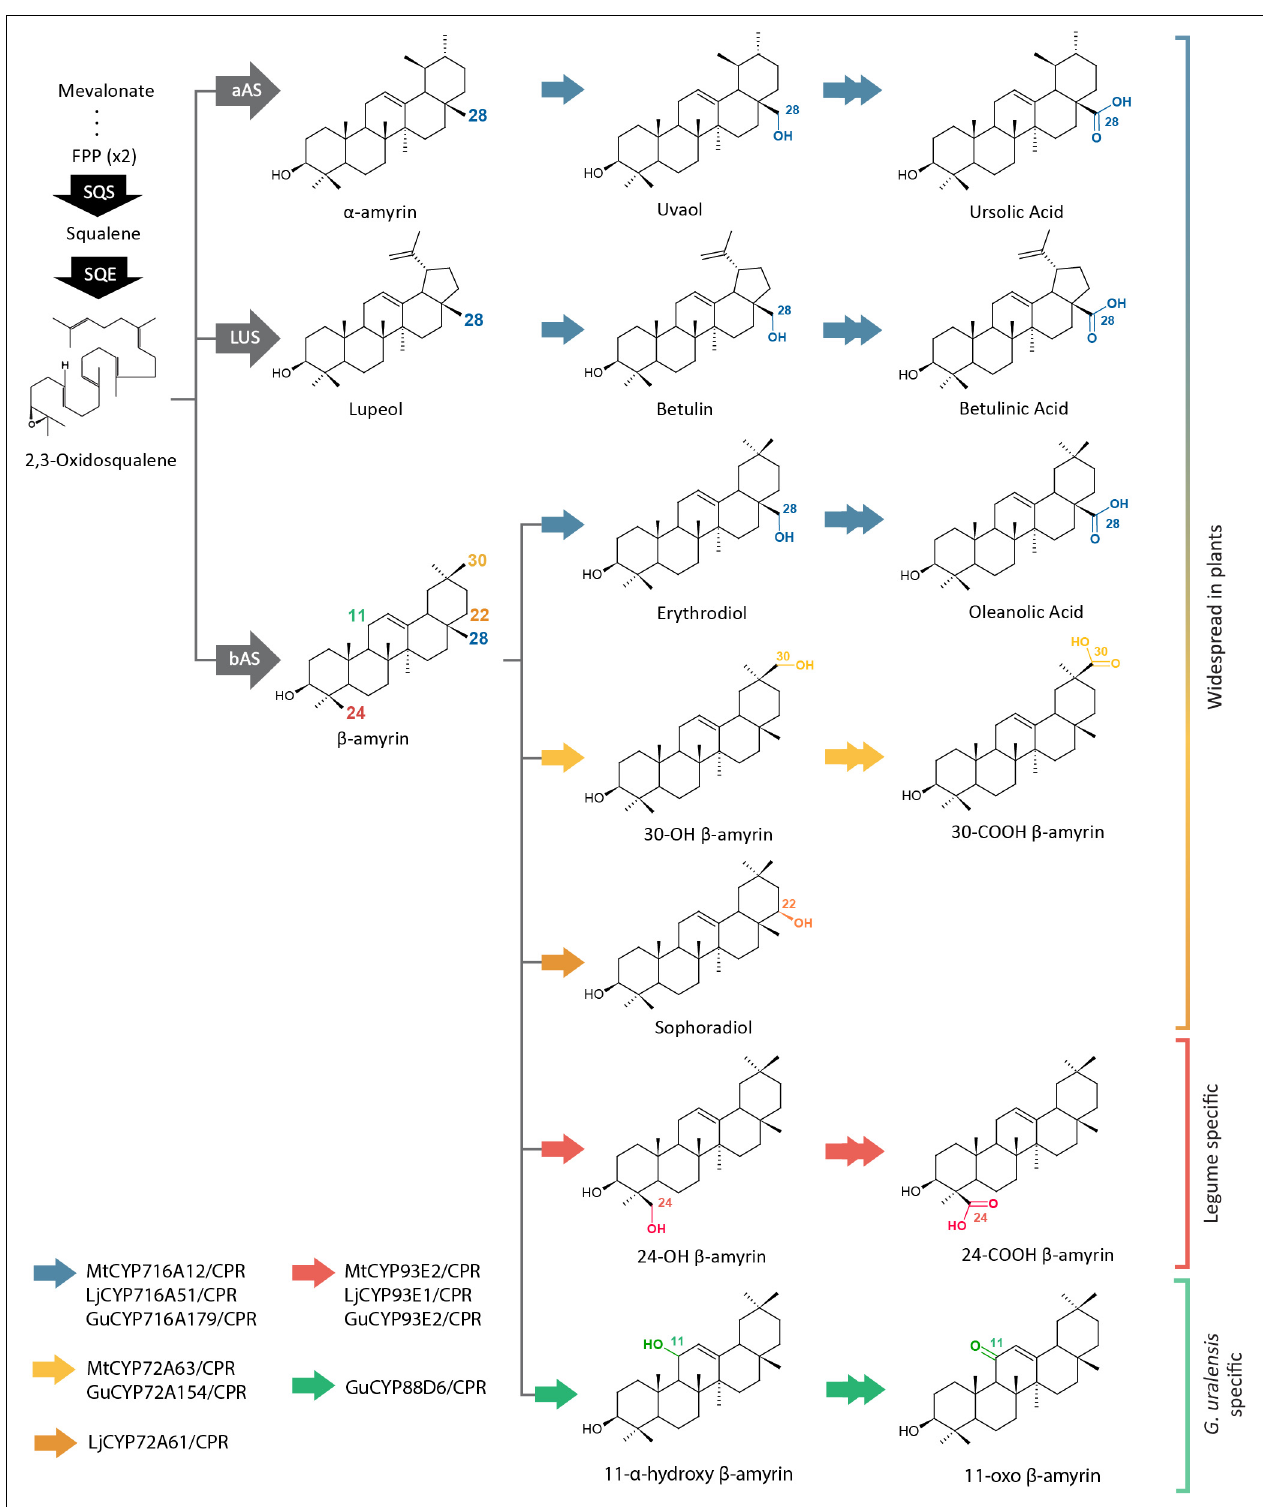
FIGURE 1 | Triterpenoid biosynthetic pathways of several CYP families from Medicago truncatula (Mt) , Lotus japonicus (Lj), and Glycyrrhiza uralensis (Gu). Single and double arrows indicate one and two oxidation steps, respectively. CYP, cytochrome P450; FPP, farnesyl pyrophosphate; SQS, squalene synthase; SQE, squalene epoxidase; bAS, β -amyrin synthase; aAS, α -amyrin synthase; LUS, lupeol synthase.